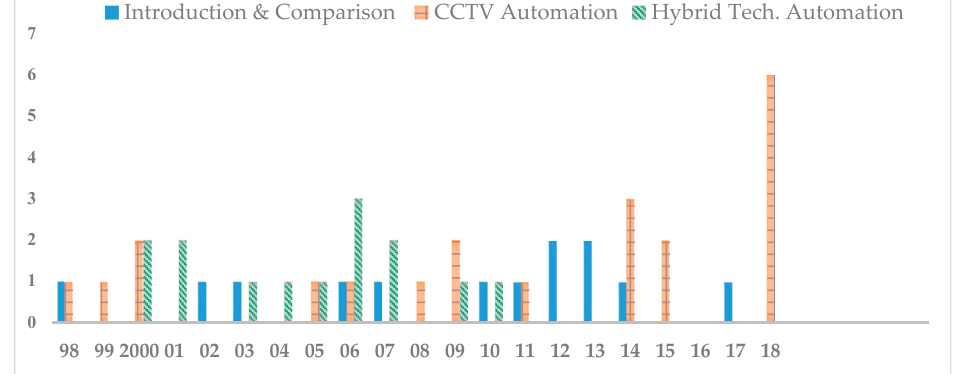
Figure 4. Number of research on inspection methods in each year.